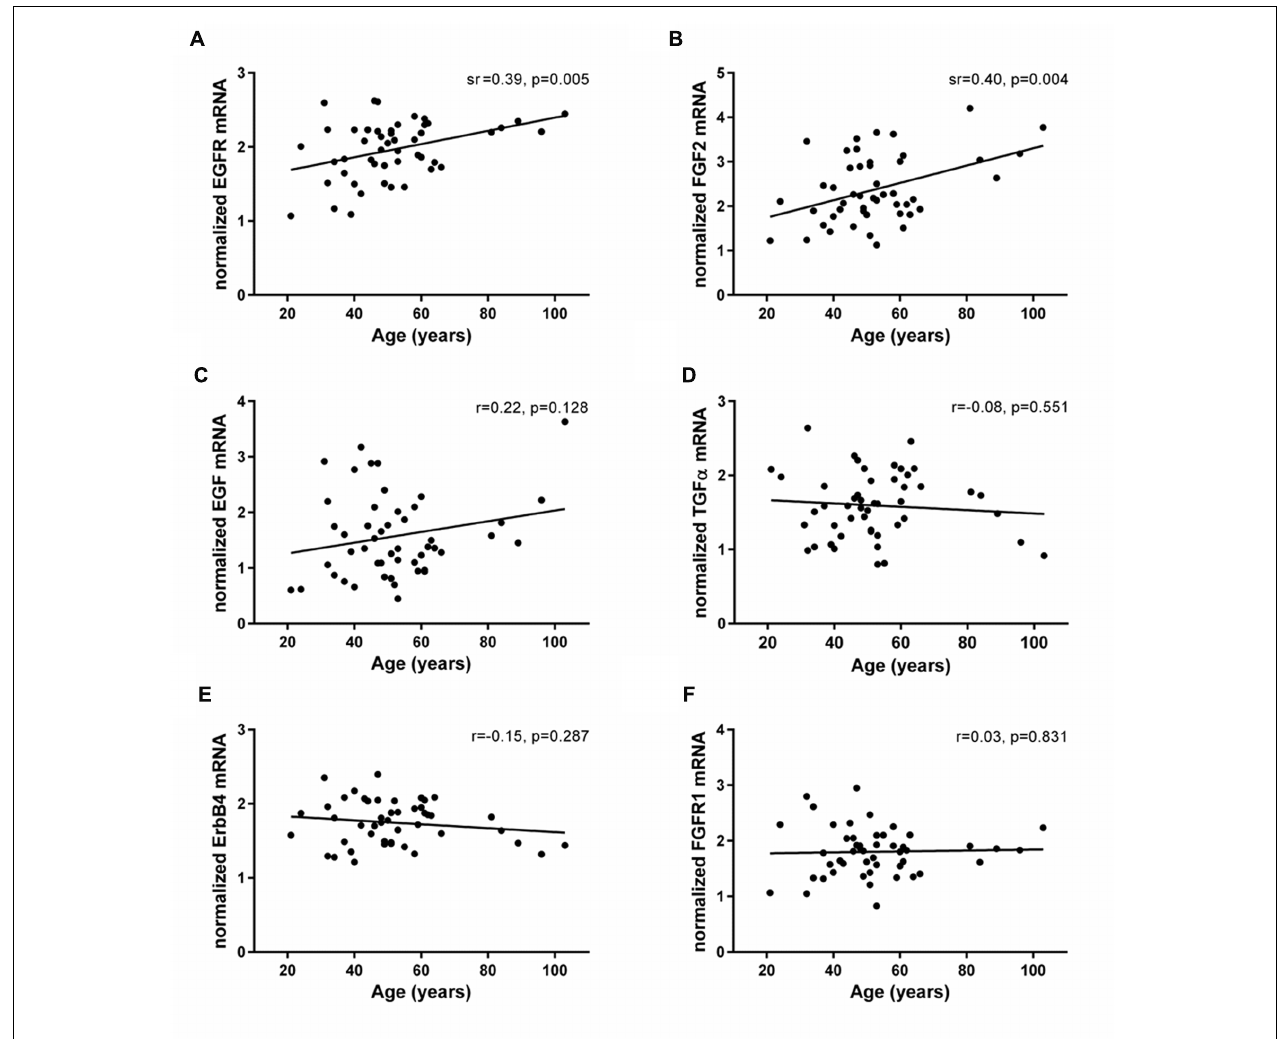
FIGURE 4 | Expression of EGF- and FGF-related family members in the human SEZ throughout adulthood. Transcript levels of EGF- and FGF-related growth factors (EGF, TGF α , and FGF2) and receptors (EGFR, ErbB4, and FGFR1) were measured by qRT-PCR and normalized to the geometric mean of two housekeeping genes. EGFR (A) and FGF2 mRNAs (B) were positively correlated with age in the human SEZ, whereas expression of EGF (C) , TGF α (D) , ErbB4 (E), and FGFR1 (F) remained stable throughout adult life. r, Pearson’s product-moment correlation coefficient; sr, semi-partial correlation